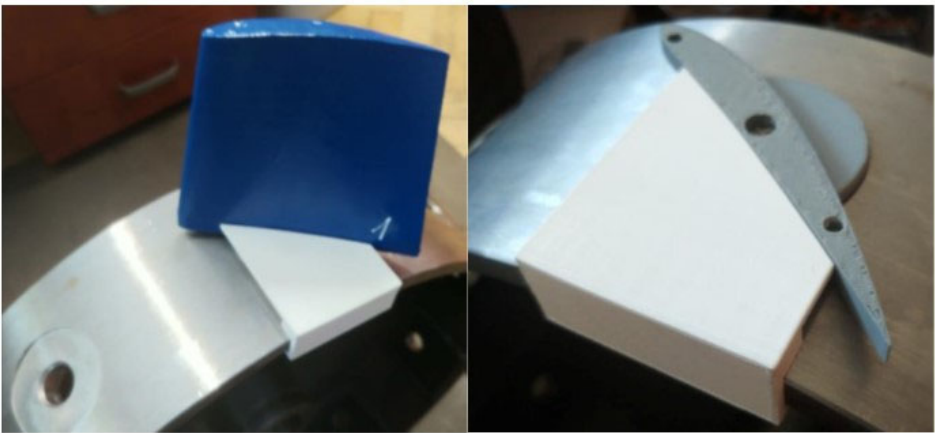
Figure 17. Determination of the correct blade angle.